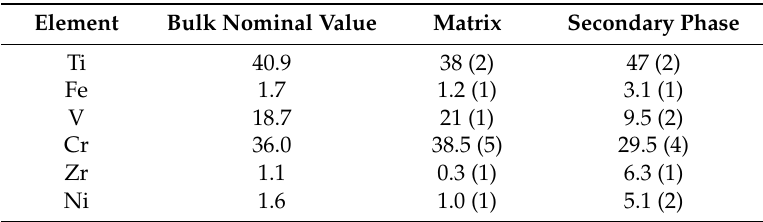
Table 3. Nominal and measured atomic percentage of the as-cast co-melt Ti 1.26 V 0.315 (FeV) 0.315 Cr 1.11 + 4% Zr 7 Ni 10 alloy.